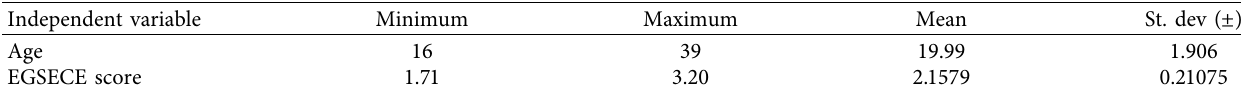
Table 2: Summary statistics of age and EGSECE